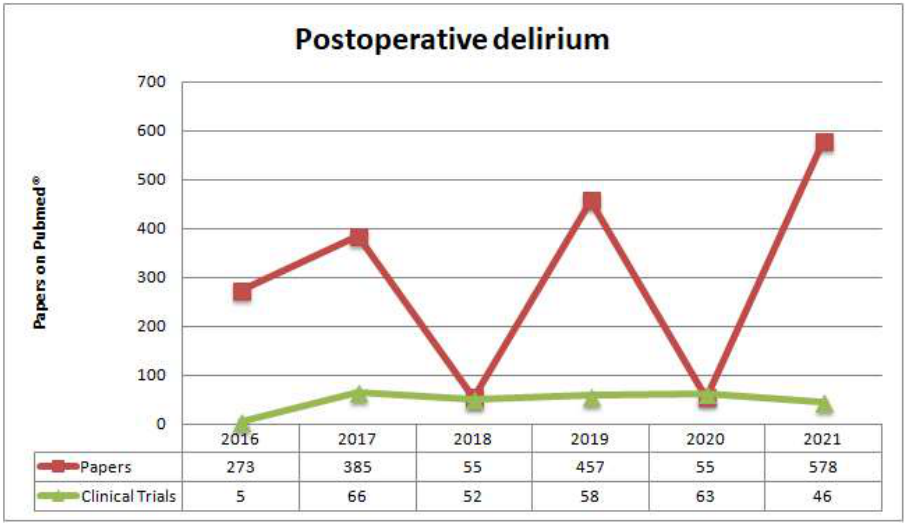
Figure 1. Recent papers published on Pubmed ® regarding postoperative delirium in the last five